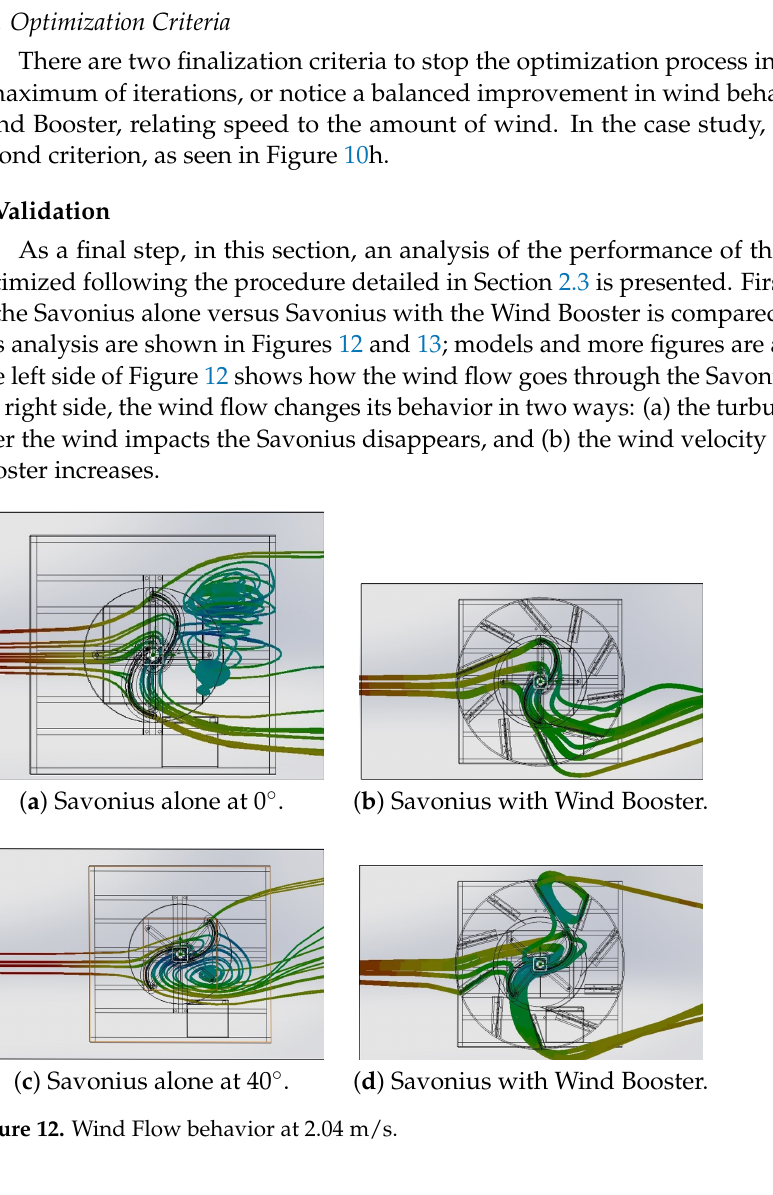
Figure 11. Evolution of the Wind Booster configuration using the bisection algorithm.